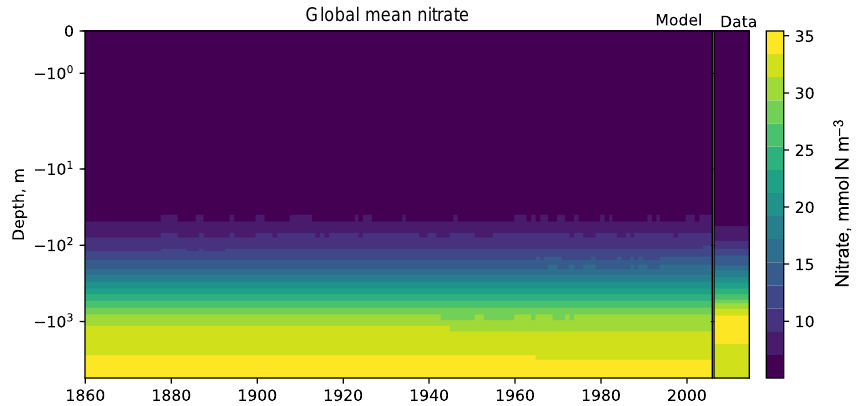
Figure 7. The time development of the global mean dissolved nitrate over a range of depths. The figure shows the same data as Fig. 6, but as a Hovmöller time series plot. The annual mean of the World Ocean Atlas nitrate climatology dataset is shown as a column on the right-hand side of the figure.